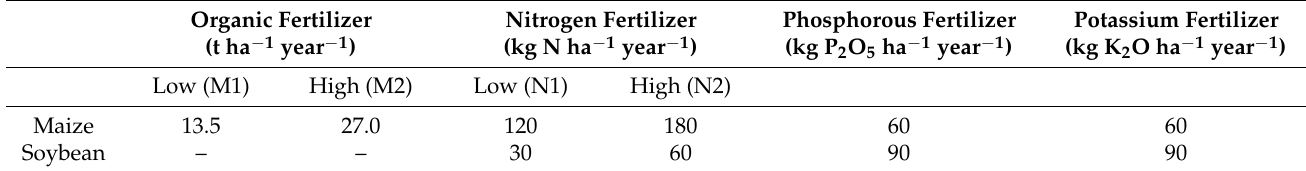
Table 1. The rates of fertilizer application during maize and soybean seasons. Organic